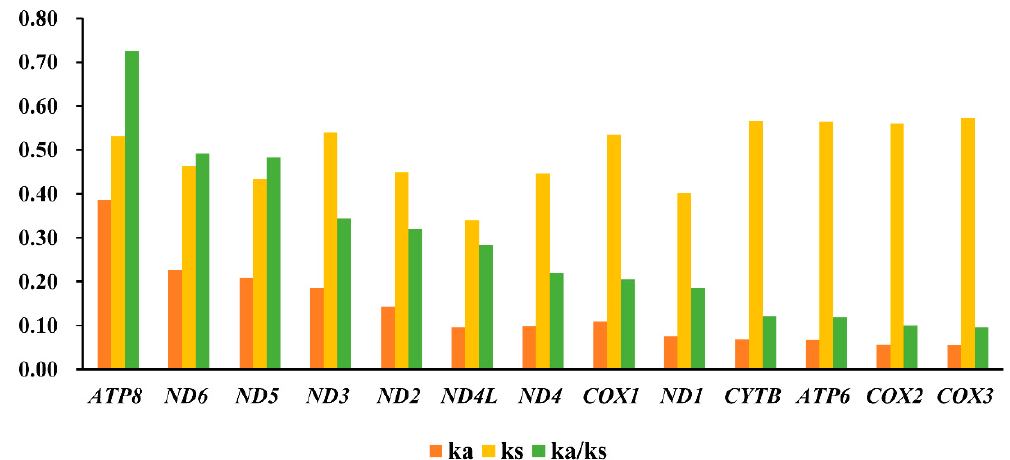
Figure 3. Evolution rate of 13 PCGs of the Polypedilum generic complex mitogenomes. Ka refers to non-synonymous nucleotide substitutions, Ks refers to synonymous nucleotide substitutions, Ka/Ks refers to the selection pressure of each PCG. The abscissa represented 13 PCGs, and the ordinate represented Ka/Ks values.